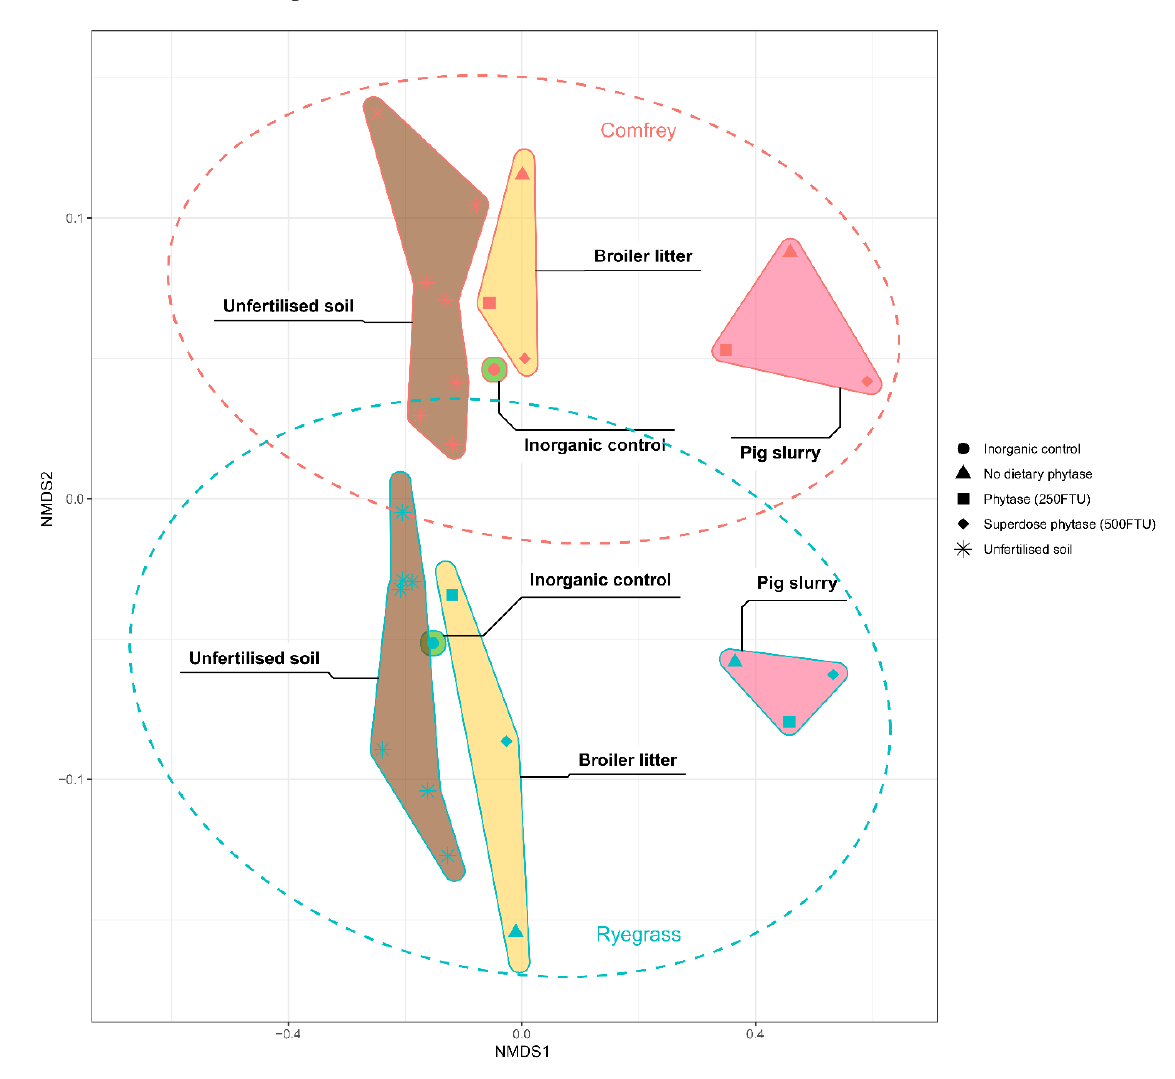
Figure 5. Non-metric multidimensional scaling (NMDS) of the soil microbiota composition based on 16S rRNA sequencing data. The category “unfertilised soil” comprises samples taken at the beginning of the experiment, i.e., before the fertiliser application. Alteration of the microbiota composition was pronounced due to application of organic amendments (pig slu, chicken litter) generated by varying amounts of phytase feed additives (no phytase, phytase, superdose-phytase) in comfrey and ryegrass specimen.